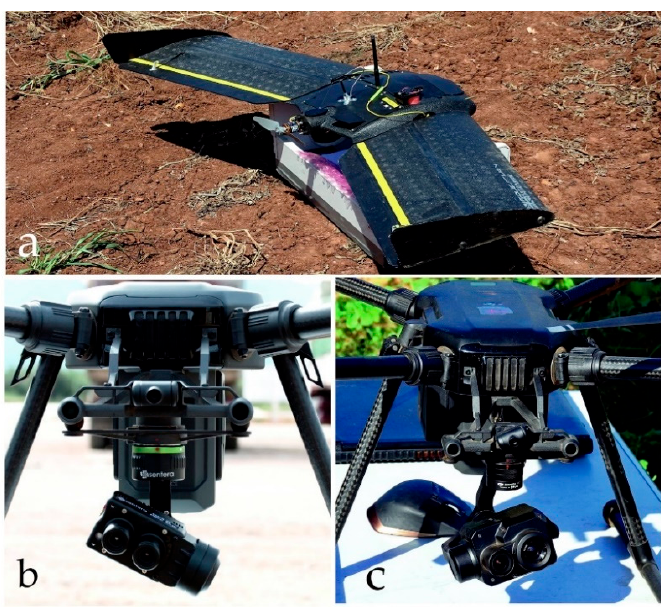
Figure 9. ( a ) The fixed-wing Q100 Datahawk; ( b ) the multispectral Sentera camera; ( c ) the thermal infrared camera Zenmuse XT2.